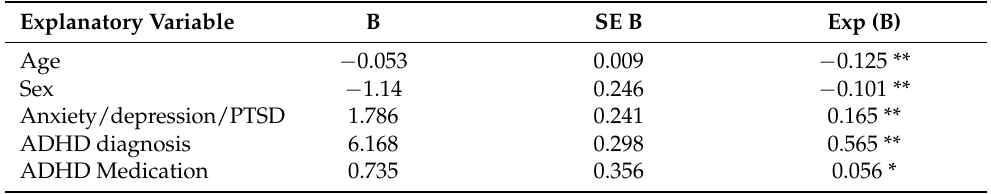
Table 2. Summary of the final hierarchical regression analysis model for variables predicting severity of ADHD symptoms as measured by the ASRS ( n = 1324).